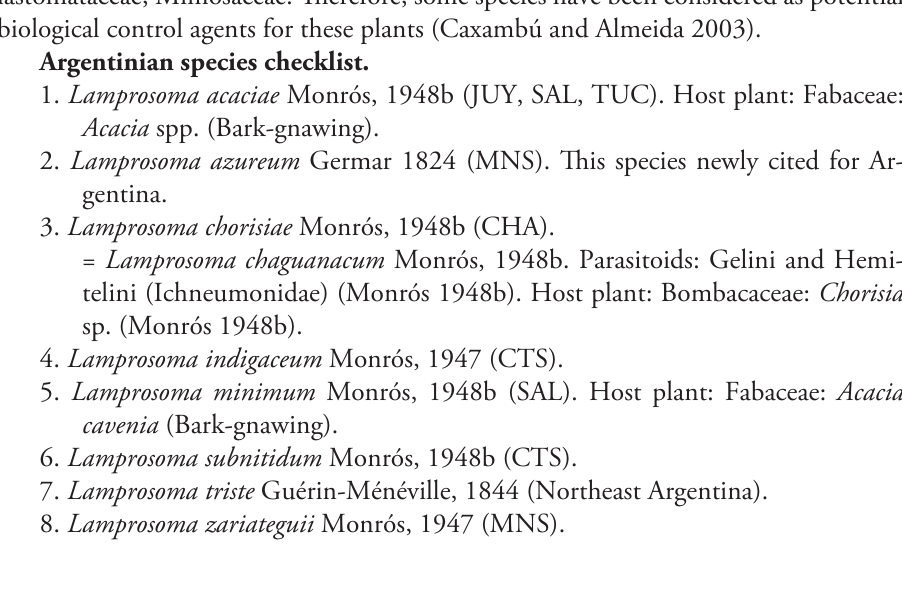
Distribution. Nearctic, Neotropical, in Argentina limited to north, and north- eastern